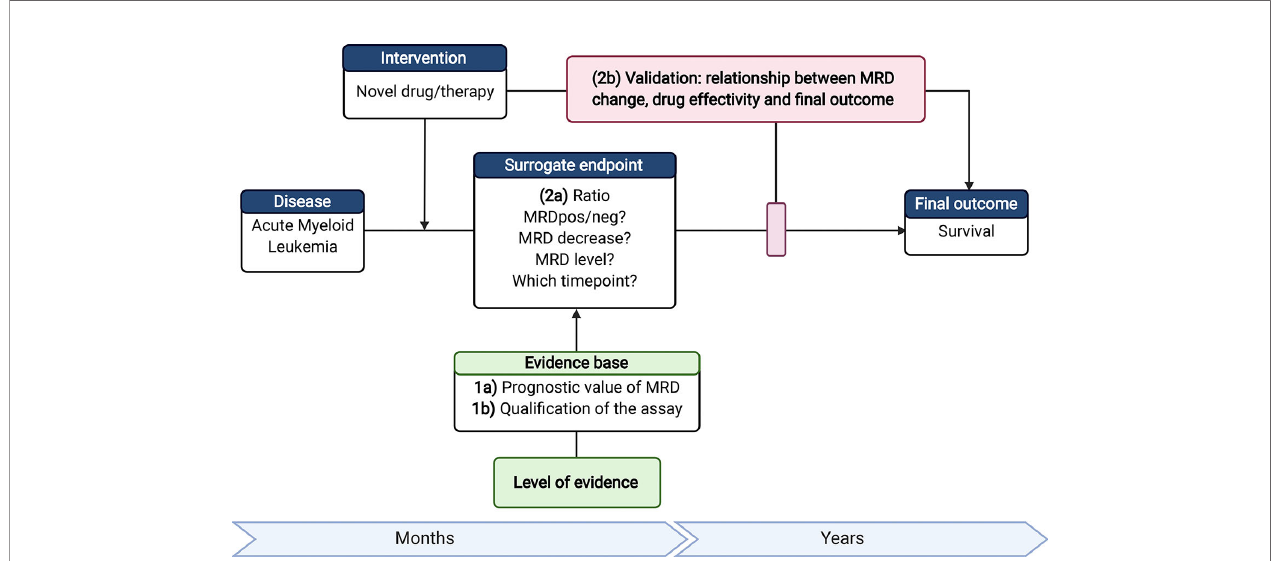
FIGURE 3 | Requirements to make MRD eligible as a surrogate endpoint. 1a) Next to the current evidence on the prognostic value of MRD; 1b) the MRD assay should be quali fi ed (accurate MRD measurements with established lower limit of quanti fi cation). 2a) For use of MRD as surrogate endpoint, the time point of MRD assessment and readout measures, such as threshold of MRD-positivity or level of decrease (log-reduction), should be established; 2b) Ultimately, it is required to validate the association between treatment effectivity, MRD as surrogate endpoint, and the change in outcome. Therefore, the added value of MRD as surrogate endpoint has to be shown in a clinical trial with a (novel) treatment that gives a signi fi cant survival bene fi t and a signi fi cant change in MRD using the selected readout 2a). AML, Acute Myeloid Leukemia; MFC, multiparameter fl ow cytometry; MRD, Measurable residual disease. Created with